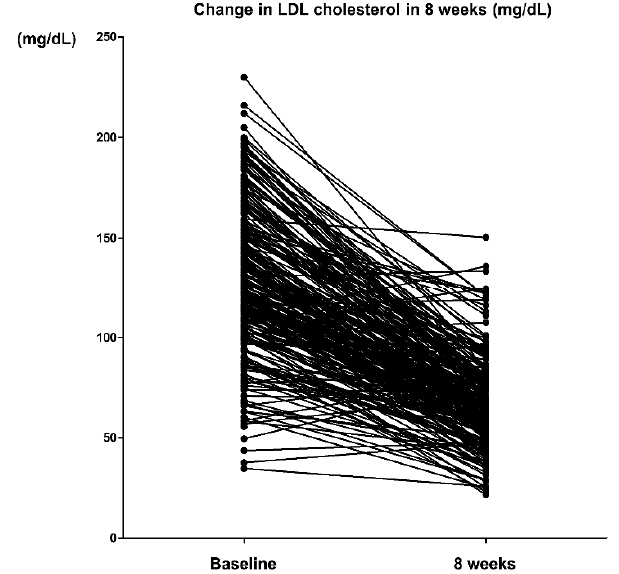
Figure 1. Change in LDL cholesterol in 8 weeks. LDL: low ‐ density lipoprotein